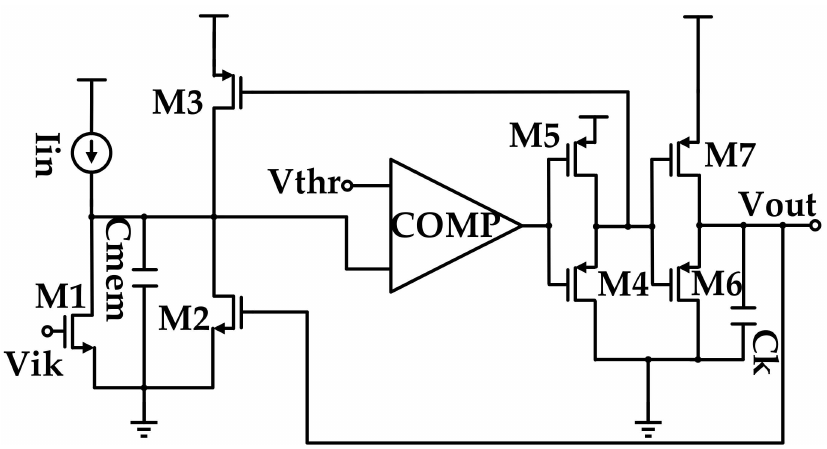
Figure 4. The artificial neuron with the reference voltage V thr . As drawn in